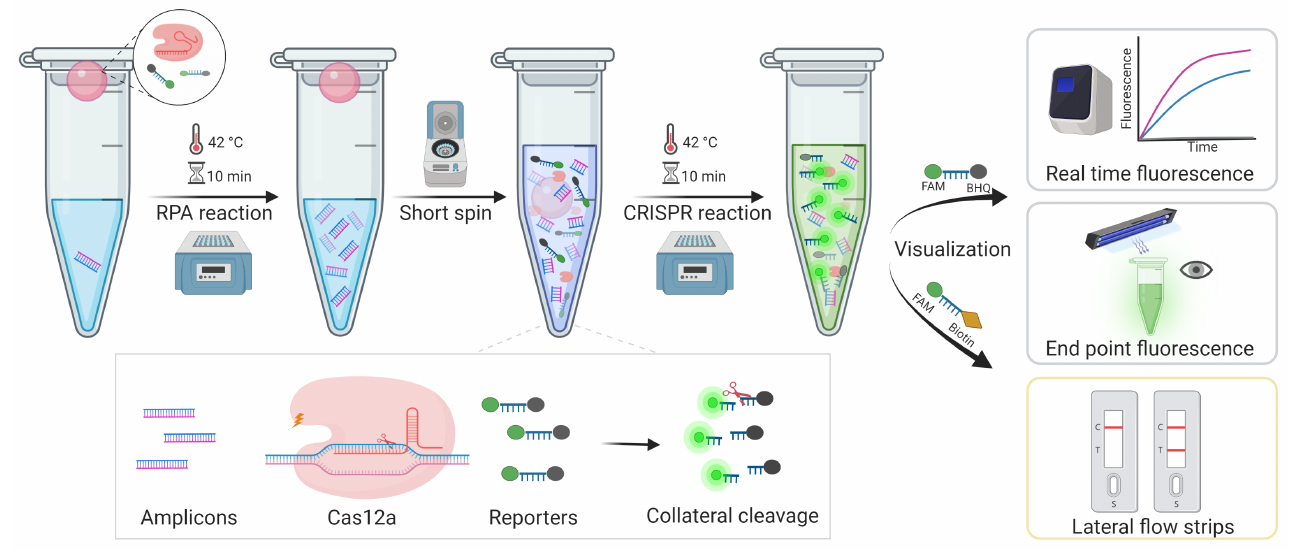
Figure 1. The workflow of the overall process for MRSA rapid detection based one-tube RPA- CRISPR/Cas12a assay within 20